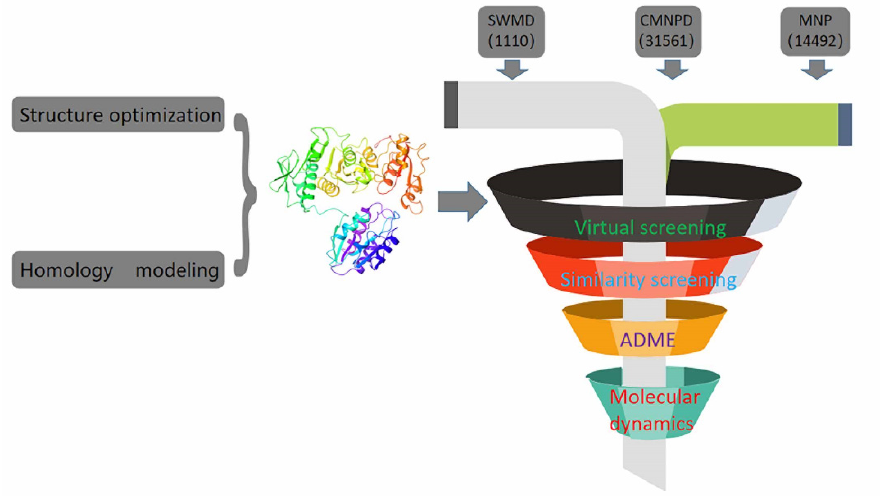
Figure 8. Execution diagram of virtual screening and molecular dynamics. Table 3. The docking fraction of compound 46604 and 46608 with the inhibitor.